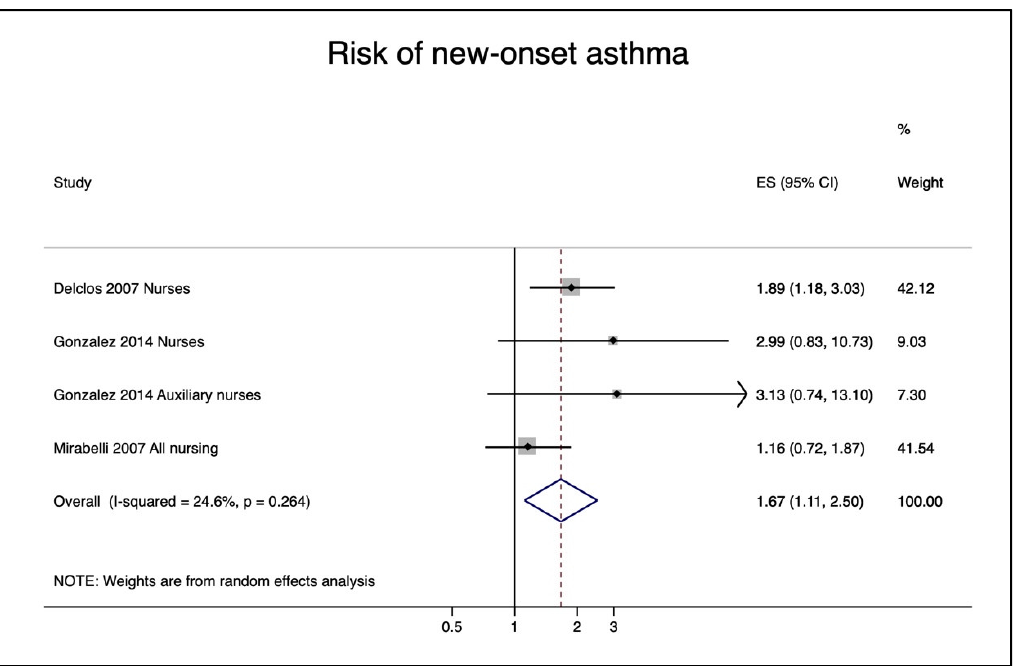
Figure 3. Pooled risks of new-onset asthma in nurses exposed to cleaning/disinfectant agents. Int. J. Environ. Res. Public Health 2021 , 18 , x FOR PEER REVIEW